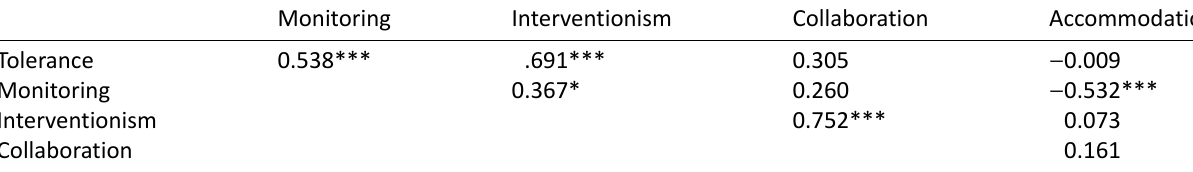
Table 3. Intercorrelations among journalistic role perceptions.